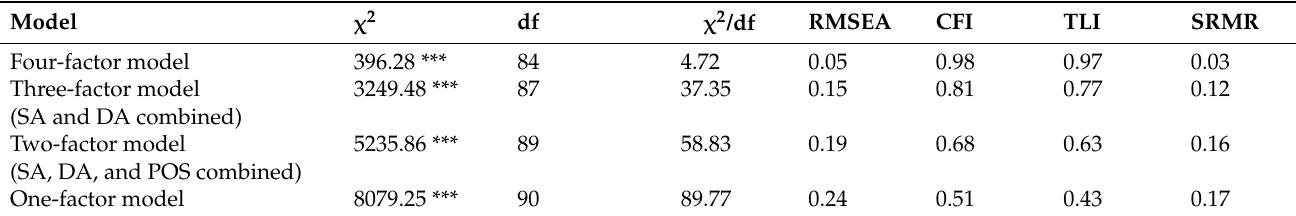
Table 1. Results of confirmatory factor